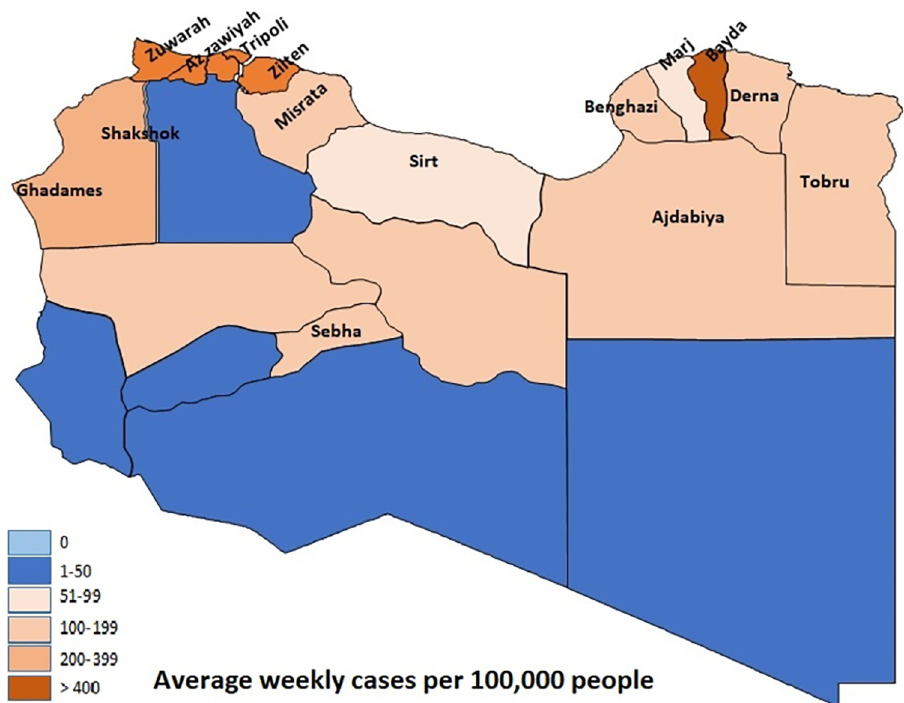
Fig 2. The geographic distribution of SARS-COV-2 infection in Libya before and after vaccine. Average weekly cases per 100,000 people. SARS-COV-2 infection in Libya before vaccine.